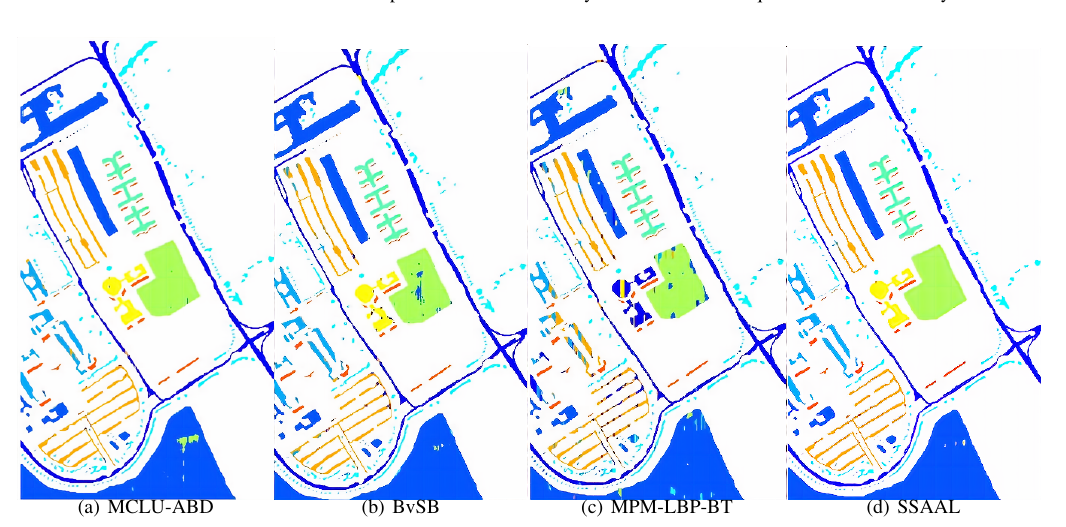
Table 8. Classification accuracies and computation time obtained by different AL techniques on Pavia University dataset.